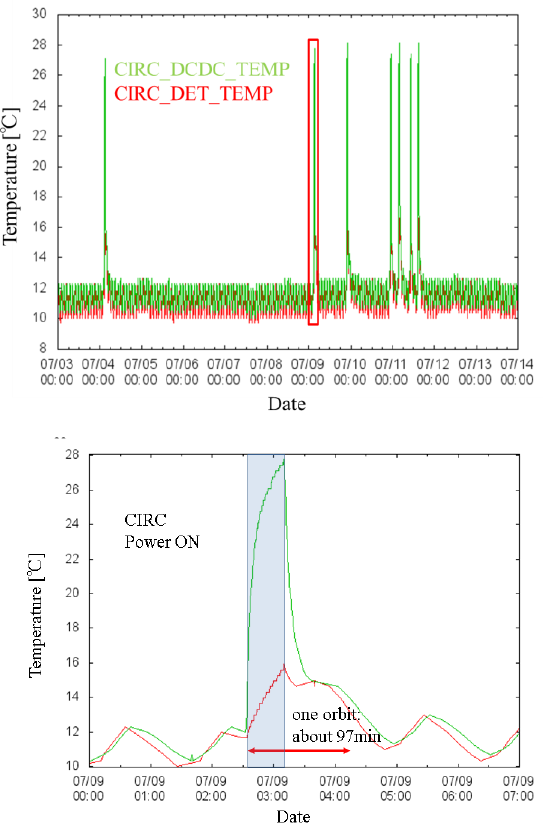
Figure 5. (Upper panel) Temperature telemetry during the initial check out. (Under panel) Extended figure of red box in the upper panel.